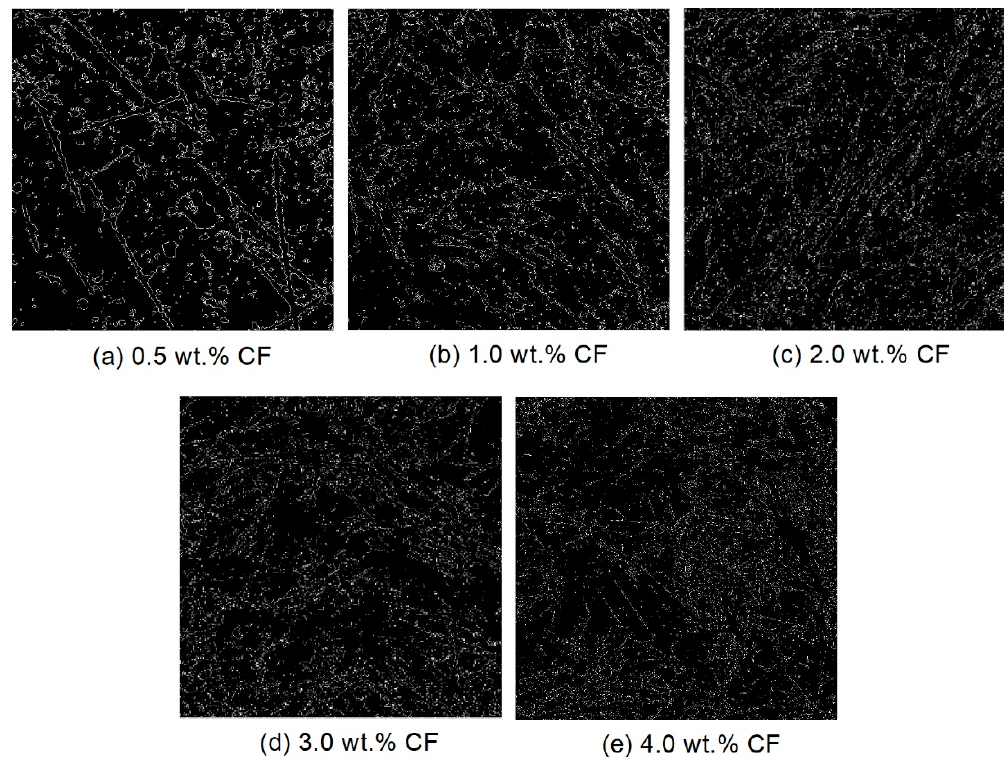
Figure 13. Sobel operator contour extraction of the carbon fibers of the contact-hardening composites with different contents: ( a ) 0.5 wt.%; ( b ) 1.0 wt.%; ( c ) 2.0 wt.%; ( d ) 3.0 wt.%; ( e ) 4.0 wt.%.